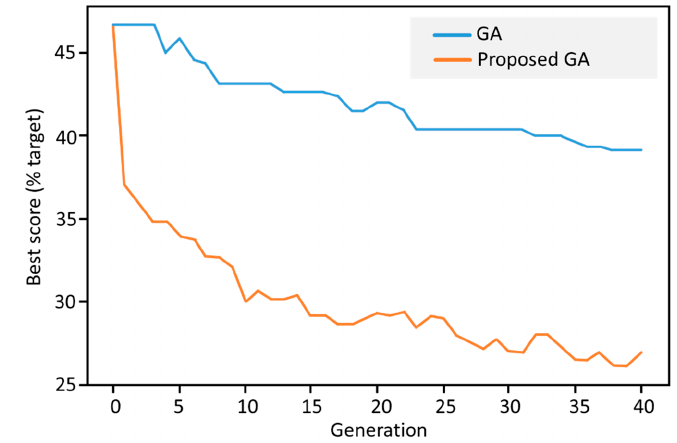
Figure 12. Convergence of the GA (Genetic Algorithm) method and the proposed method.